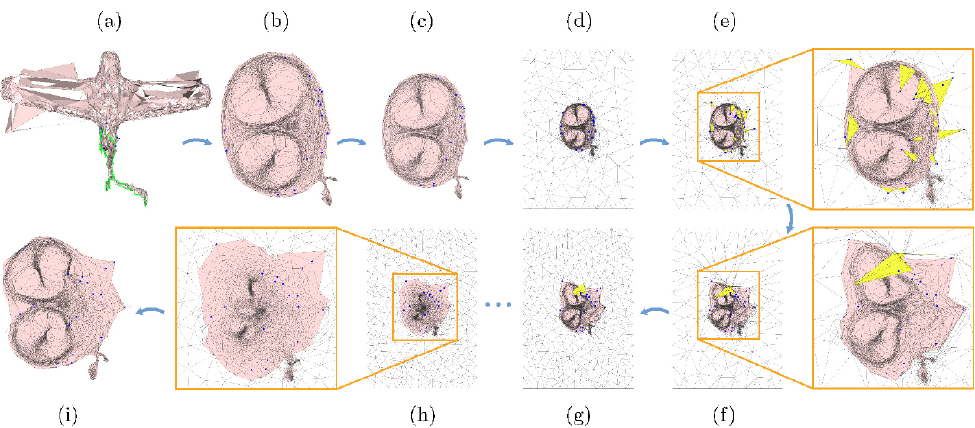
Fig. 4 Workflow of our method. Given an input triangle mesh (a), an initial globally injective parameterization P 0 is computed using Ref. [11] (b). We transform P 0 similarly to reduce distances between the current positions of constrained vertices and the target positions (c) and construct the scaffold mesh S using the CDT algorithm (d). Afterwards, we move the constrained vertices to their target positions, which may flip triangles (e), and then remove flips using Ref. [8] until termination (f). If there are flipped triangles in (f), we first perform an edge-based remeshing algorithm on S to improve its mesh quality (g) and then remove flips. This remeshing–removing process is iteratively conducted until no flips exist (h). Finally, we reduce the distortion while fixing the constrained vertices using Ref. [11] (i). ( P 0 in (c) and (d) has the same size; it is scaled in (d) for